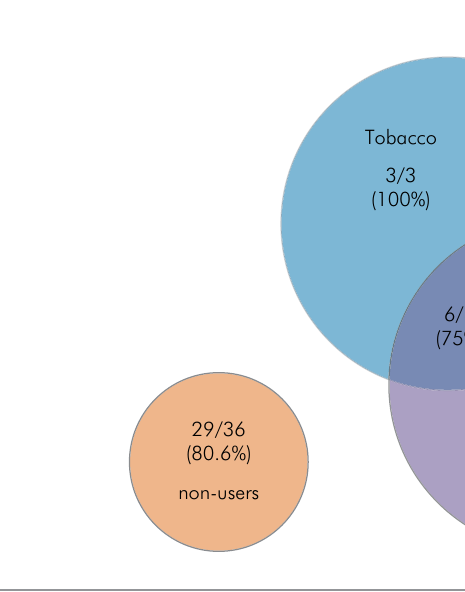
Figure. Venn diagram showing HPV positivity (86/105) in users and nonusers of